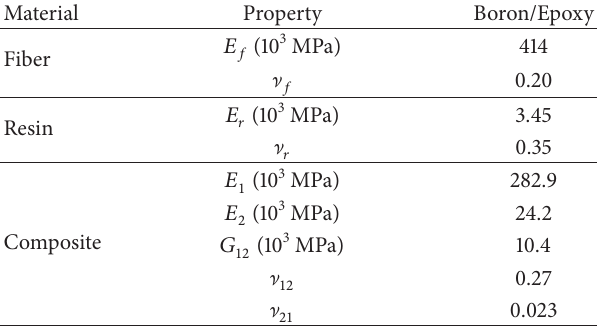
Table 1: Properties of composites used to obtain numerical